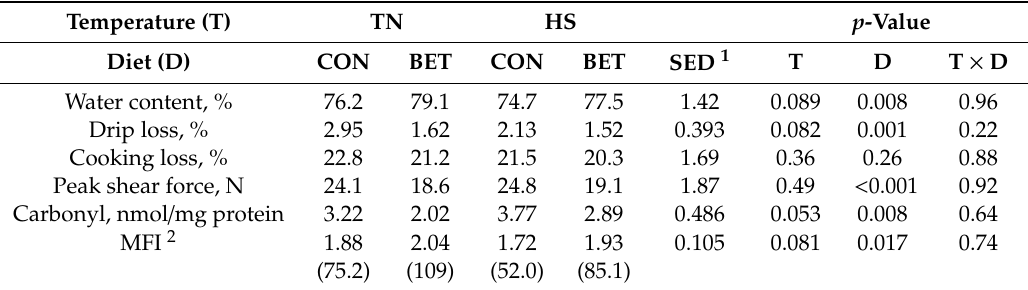
Table 4. E ff ect of betaine (BET) on chicken breast ( pectoralis major ) objective eating quality measures after being housed under thermoneutral (TN) and heat stress (HS) conditions.